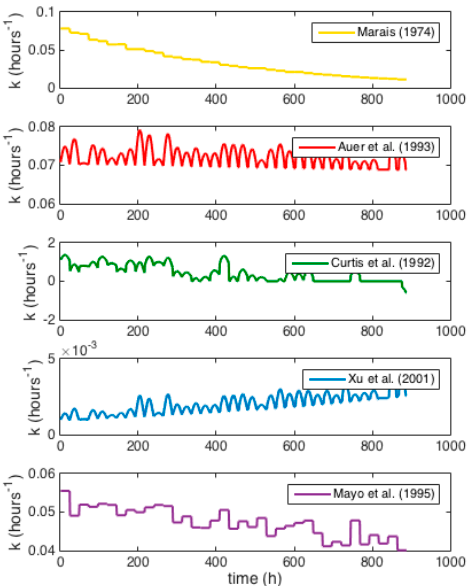
Figure 6. Predicted mortality rate constants ( k ) of the 5 different models.